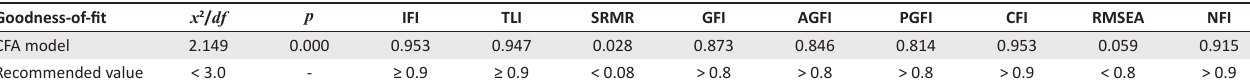
TABLE 10: Modification indices for model fit Goodness-of-fit CFA model